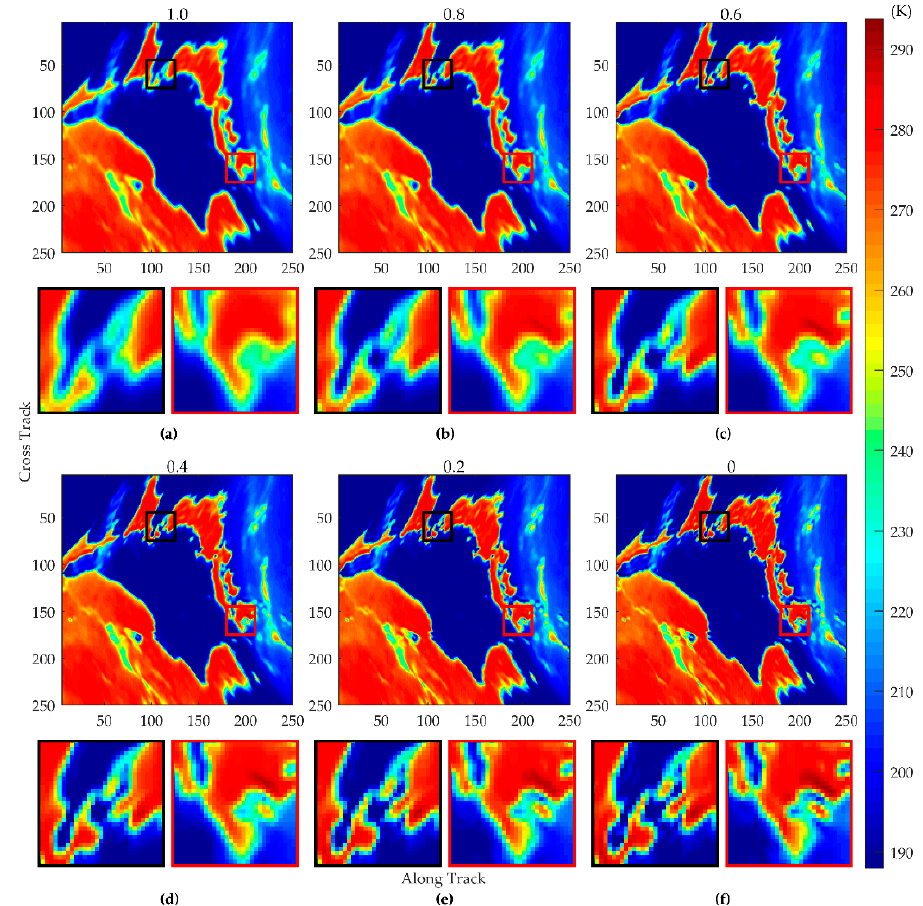
γ N γ . (a) Output of adjustable a a . ( a ) Output of adjustable network